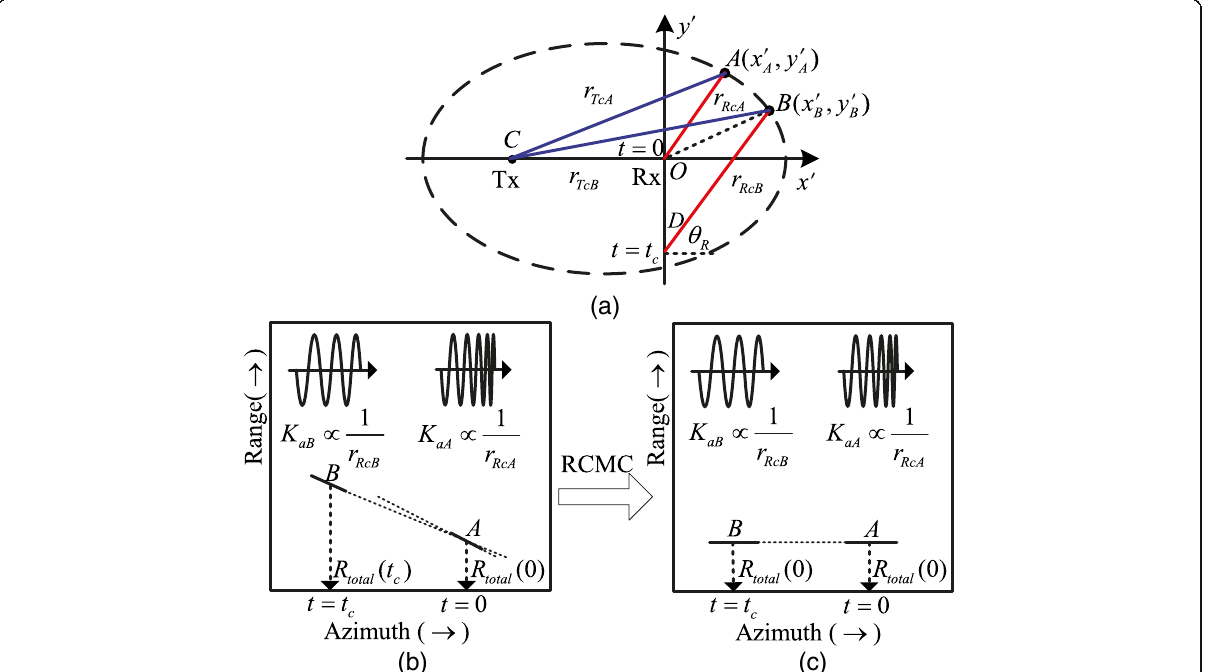
Fig. 9 a Ellipse space. A and B lie on the ellipse when they share the same R total (0; r c , t c ). b Data space before RCMC. c Data space after RCMC. Range histories of A and B have been shifted into a same range